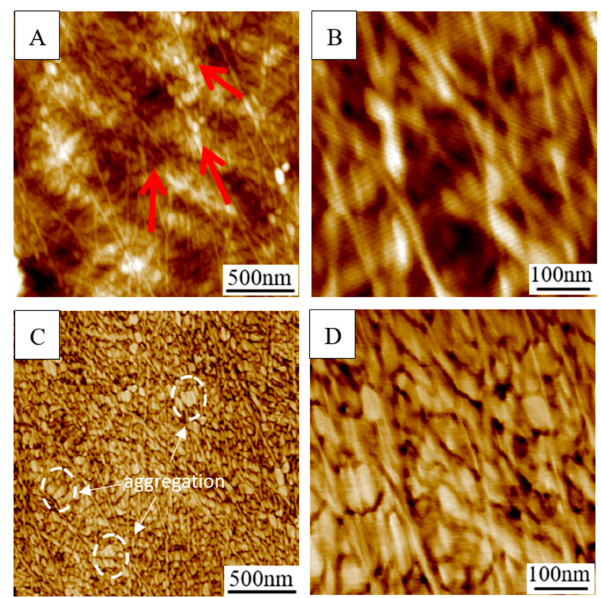
Figure 7. AFM images of the longitudinal surface of microfibrils arrangement of poplar catkin fibers treated with 5 wt.% KOH solution: ( A , B ) height images; ( C , D ) phase images.